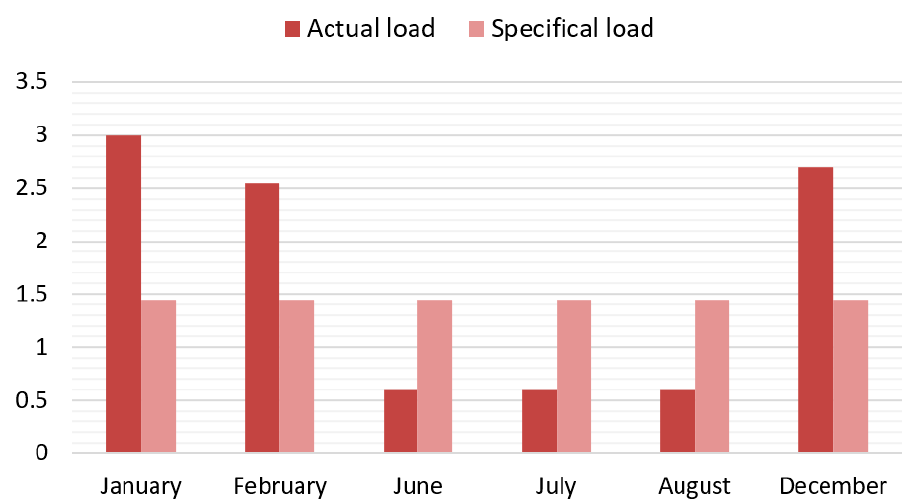
Figure 4. Comparison of actual and normalized load levels for 143 flats.